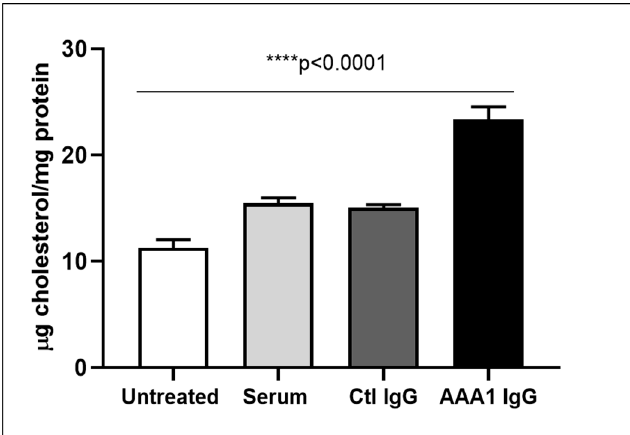
Figure 2. Anti-apoA-1 IgG increase the intracellular cholesterol content. Cell cholesterol content after exposure of cells to serum, anti-apoA-1 IgG, or control IgG, and was expressed as μ g of cholesterol /mg total protein. Data are expressed as the mean ± SD of the measurements done in triplicate and repeated three times ( n = 3). Statistical differences were determined by one-way analysis of variance (one-way ANOVA), with p ≤ 0.05 being considered significant.